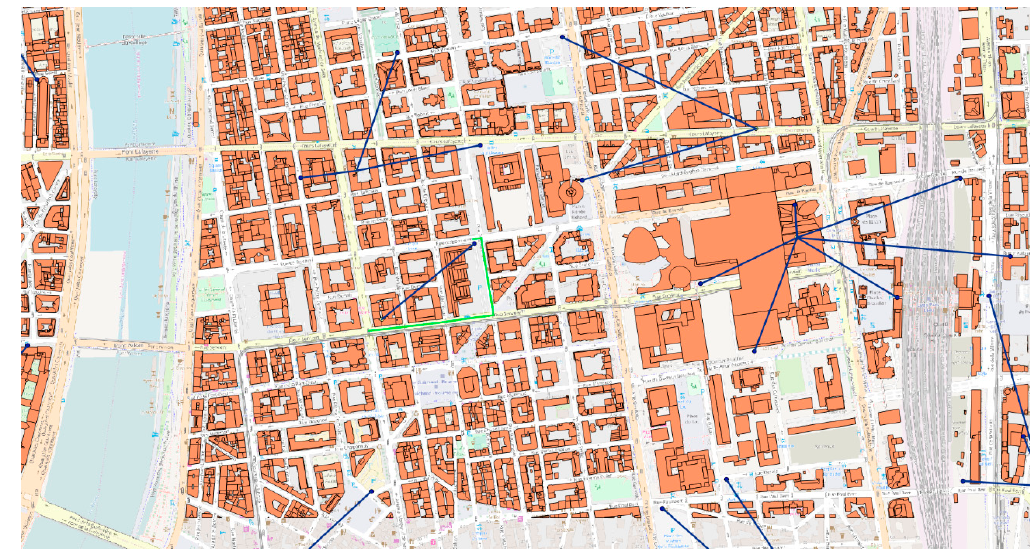
Figure 5. Feature extraction: distance from nearest atm.